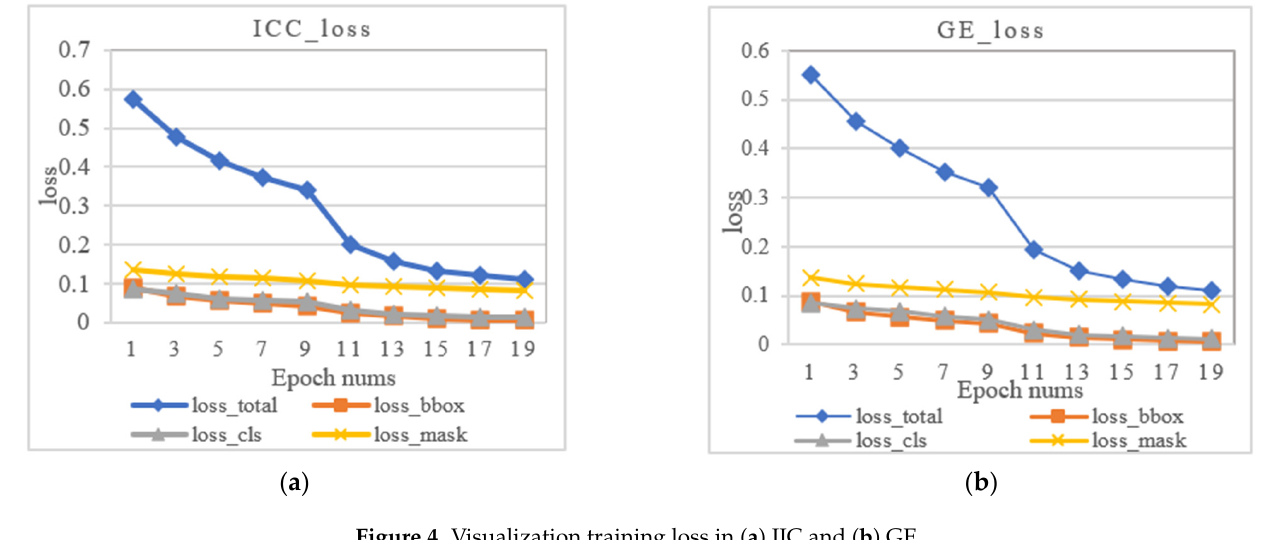
Figure 4. Visualization training loss in ( a ) IIC and ( b ) GE.